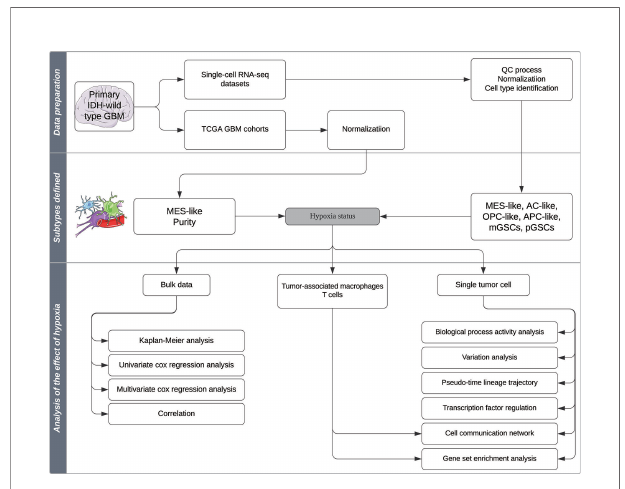
FIGURE 1 | Schematic representation of the analysis pipeline in this